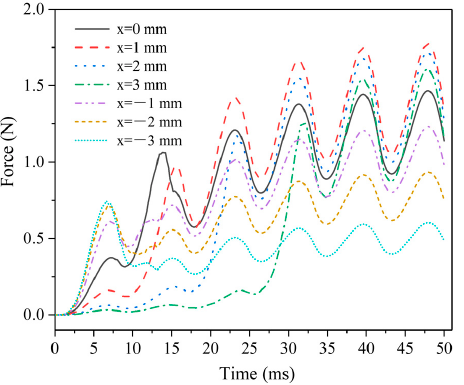
Figure 5. Electromagnetic force dynamic change curves at different positions of MIR.